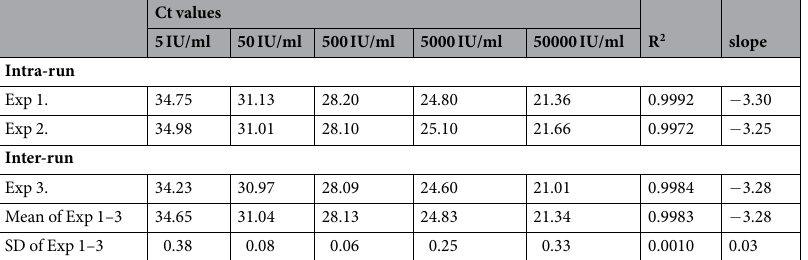
Assay 2, but were not detected by Assay 1 (Table 4). Overall, correlation of results between Assay 1 and the pro- totype assay was high (R 2 = 0.79) in contrast to Assay 2 which showed low correlation with the other two assays (Supplemental Figure S1).